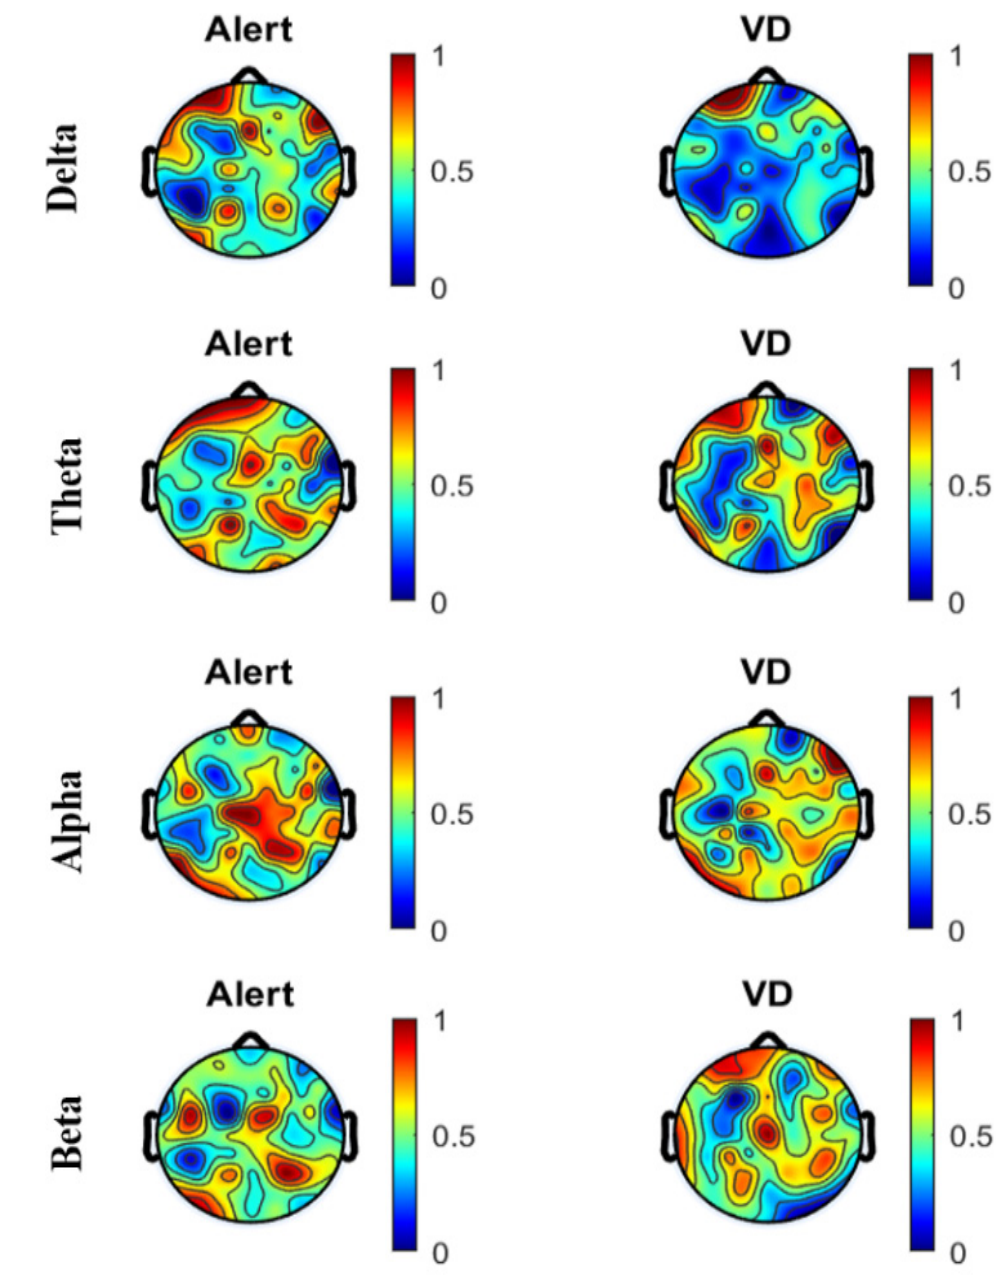
Figure 5. Comparison of PSD for all subjects under the two mental states, alert and vigilance decrement, in the four frequency bands using ICA-cleaned EEG.